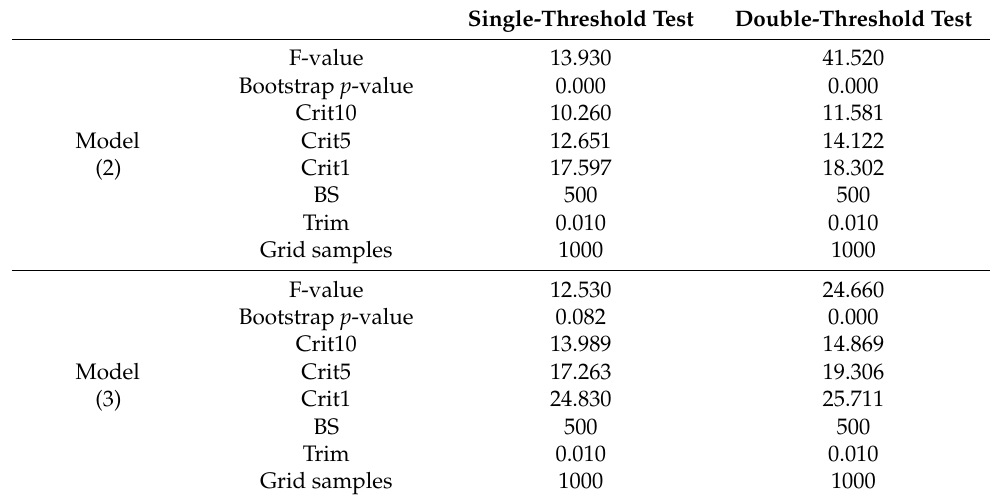
Table 5. Existence tests of threshold effects for Models (2) and (3).